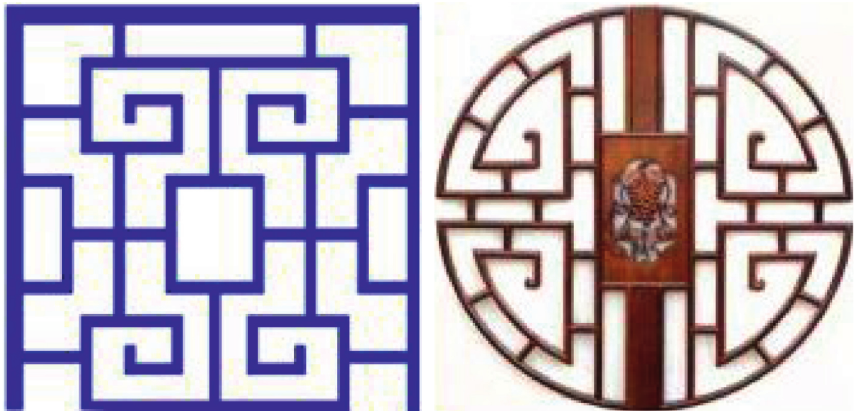
Figure 2: Photographs of the ancient Chinese “ 回 ” pane.